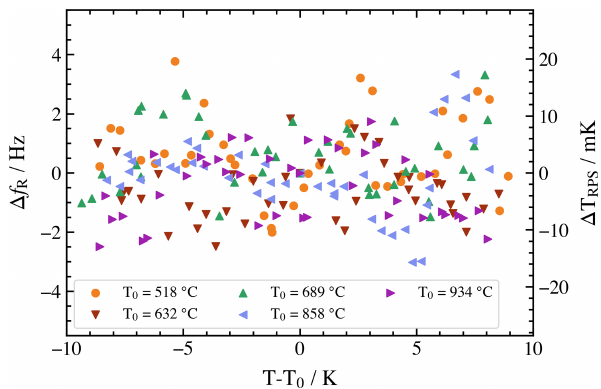
Figure 12. Deviation in the temperature-compensated resonance frequency during the heating of CTGS as recorded at five different temperature ranges. The right scale shows a change in the temper- ature during the measurement for temperature of 518 ◦ C. Measure- ments at other temperatures closely follow the behavior shown here.